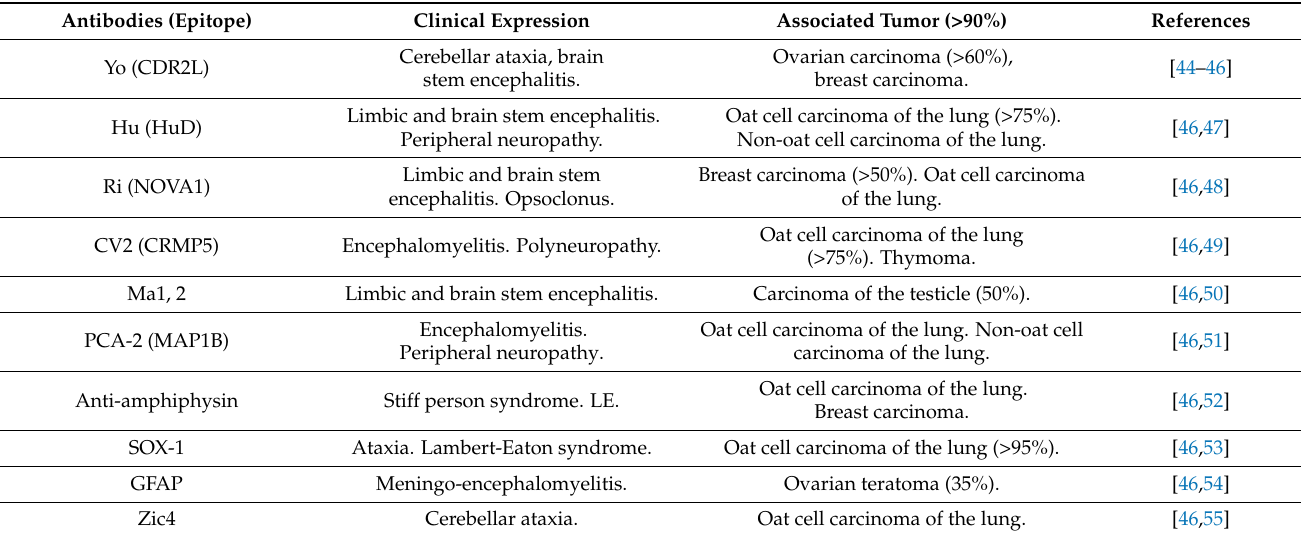
Table 1. Antibodies directed against intracellular